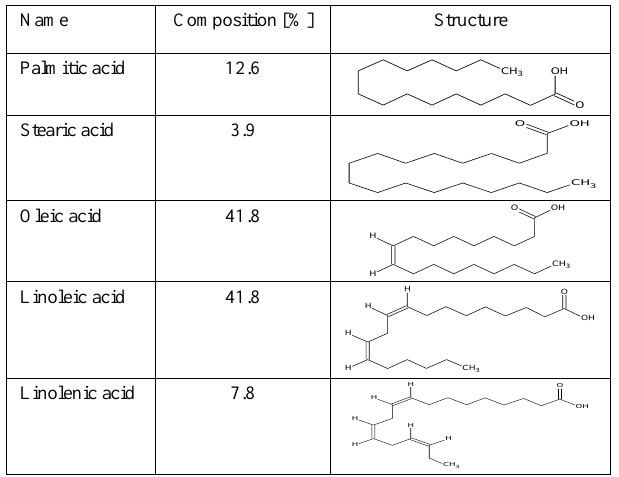
Table 1. Fatty acid composition (%) and chemical structure of jatropha curcas oil [13]